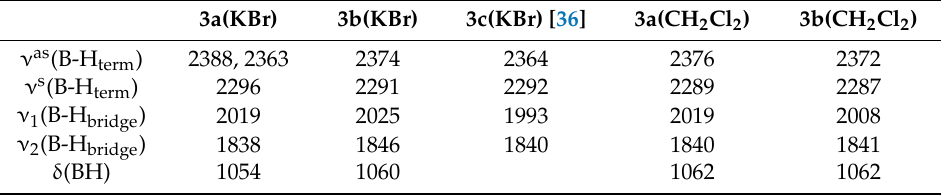
Table 1. Selected FTIR data for complexes 3a – 3c (band positions in cm − 1